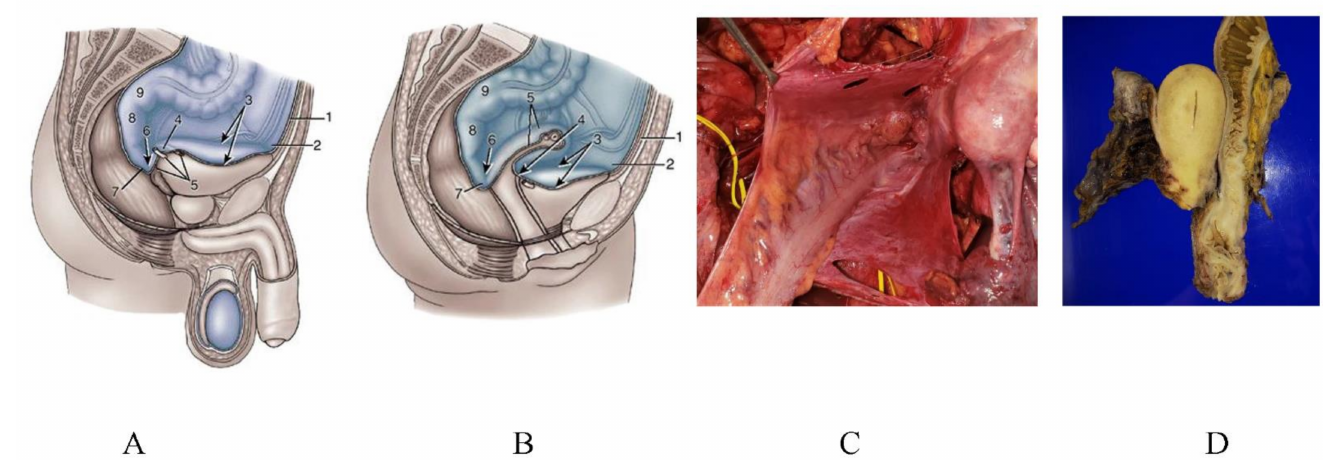
Figure 29. ( A ) Anatomical structure of the pelvic organs and peritoneum in males. ( B ) Anatomic structure of the pelvic organs and peritoneum in females. ( C ) Resection of a metastasis on a Douglas pouch by peritonectomy. ( D ) Cut surface of the resected specimen by posterior pelvic exenteration.